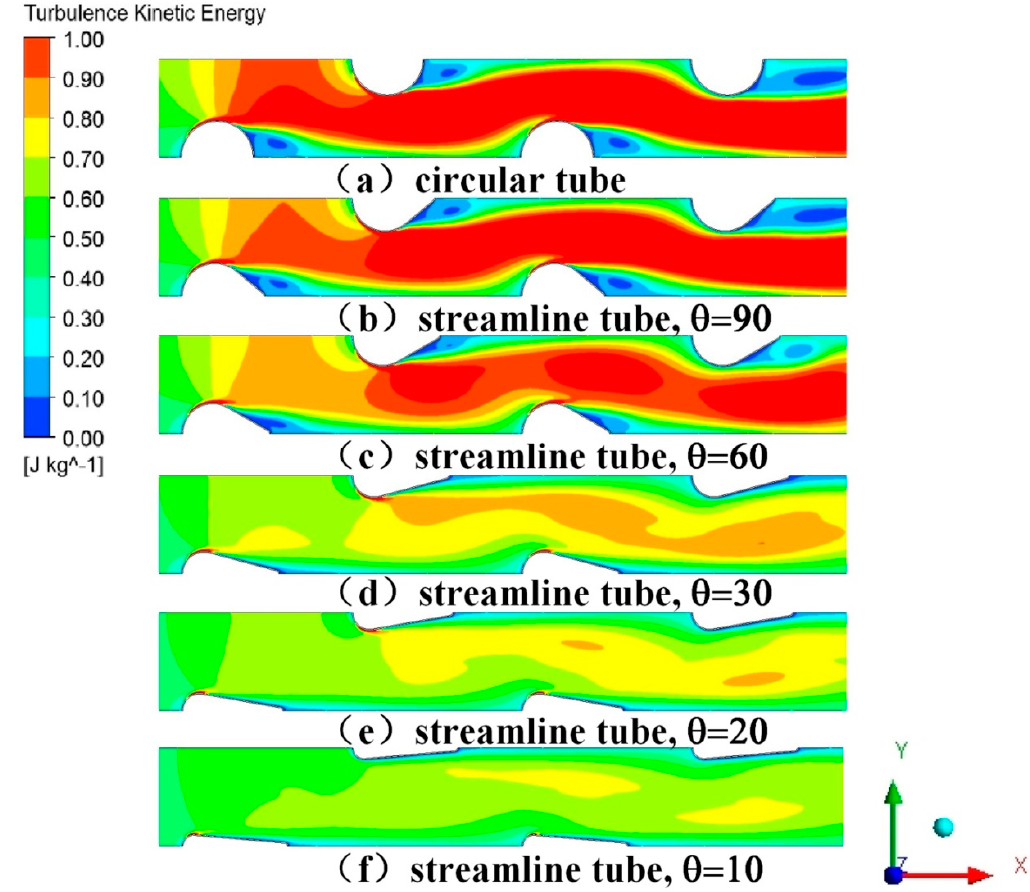
Figure 9. Turbulence kinetic energy distribution of the circular tube and streamline tube.